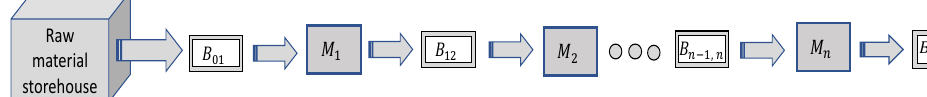
Figure 1. Sequencing of operations with decoupling